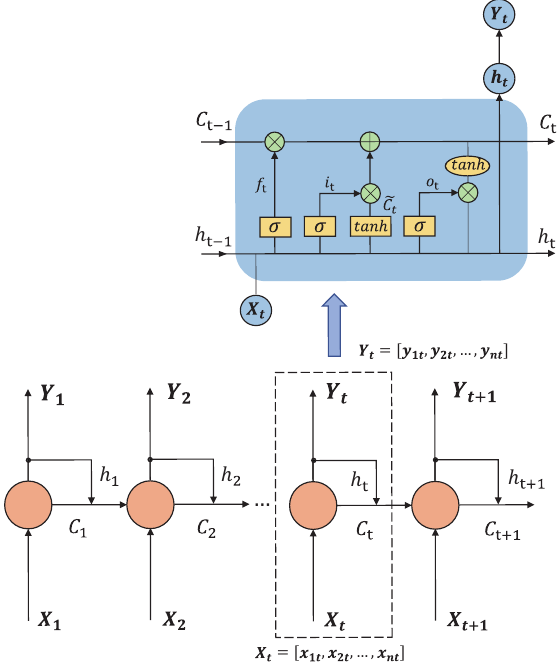
Figure 2. Structure of long short-term memory